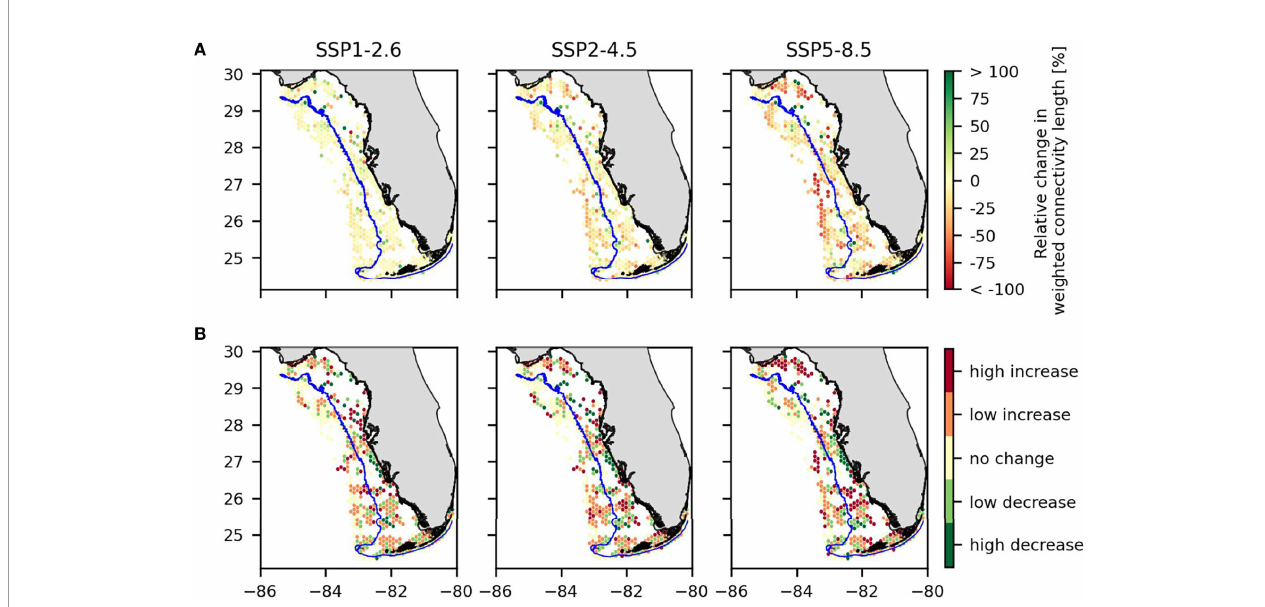
FIGURE 4 | (A) Relative change in weighted connectivity length and (B) absolute change in self-recruitment for the three climate change scenarios. The blue line represents the 30m-depth isobath separating the fi shing and non- fi shing